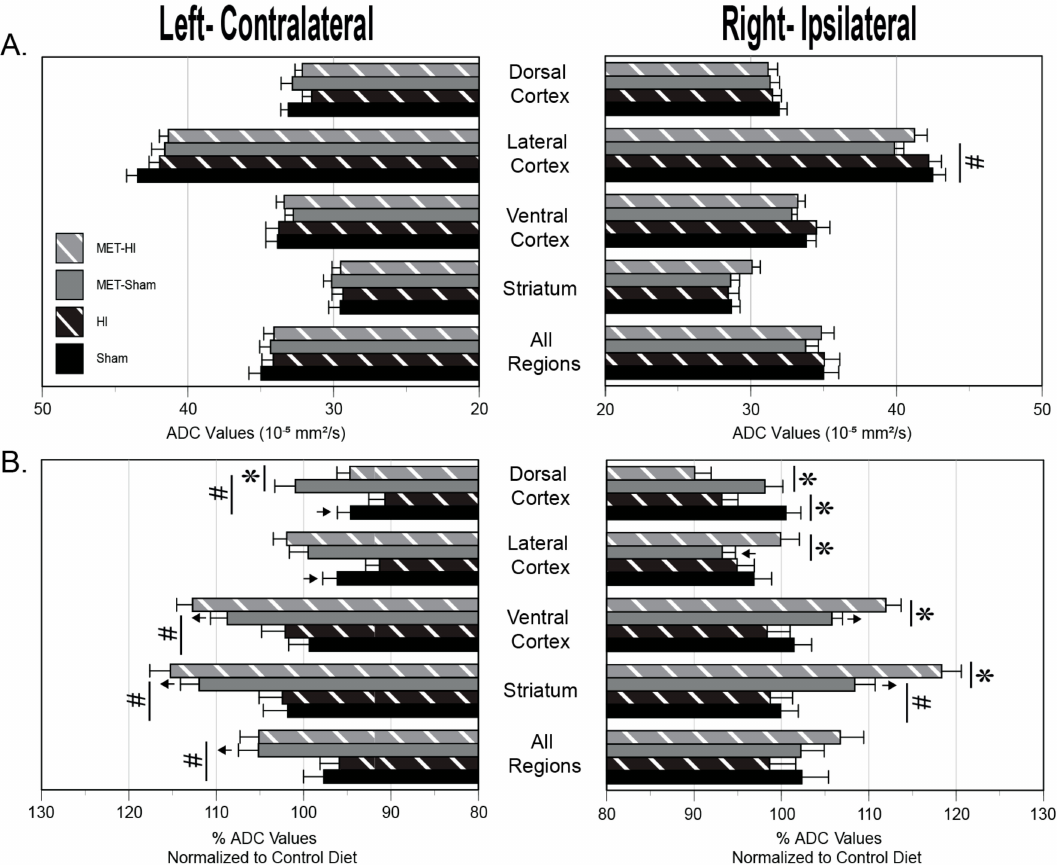
Figure 9. Effects of HI, gestational MET, and MUN on ADC values in P11/P12 pups. Regional analysis of apparent diffusion coefficients (ADC) used the same regions and layout as Figure 8. ( A ) Columns and error bars indicate SEM and show difference between MUN groups. ( B ) Columns and error bars indicate MUN values normalized to CD for each response and show MUN-induced effects. ANOVA with a post-hoc Fisher’s LSD determined the statistical significance as shown by: * for differences between Sham and HI groups and # for differences between MET-Sham and Untreated-Sham